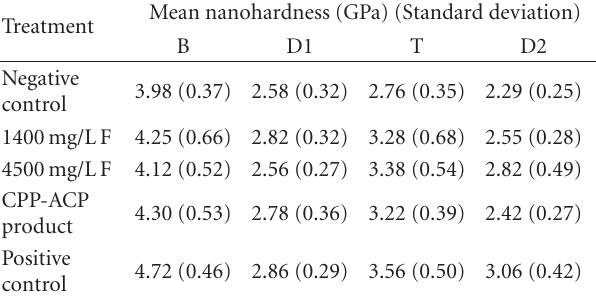
Table 1: Mean nanohardness and standard deviations (GPa) of human enamel specimens as a function of stage and treatment. B: at baseline, D1: after first demineralisation, T: after treatment, D2: after second